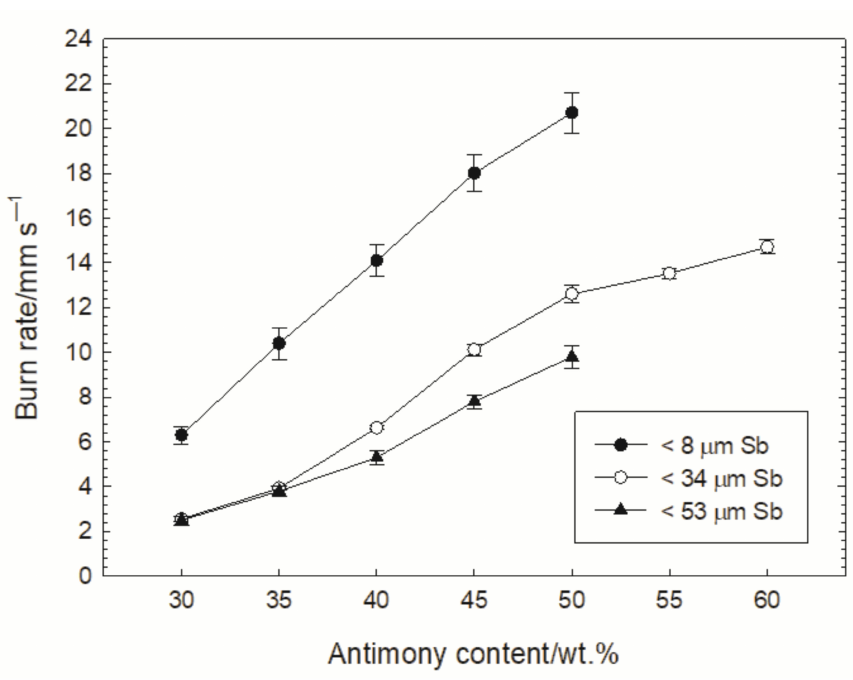
Figure 7. Influence of Sb particle size on the dependance of burning rate on antimony